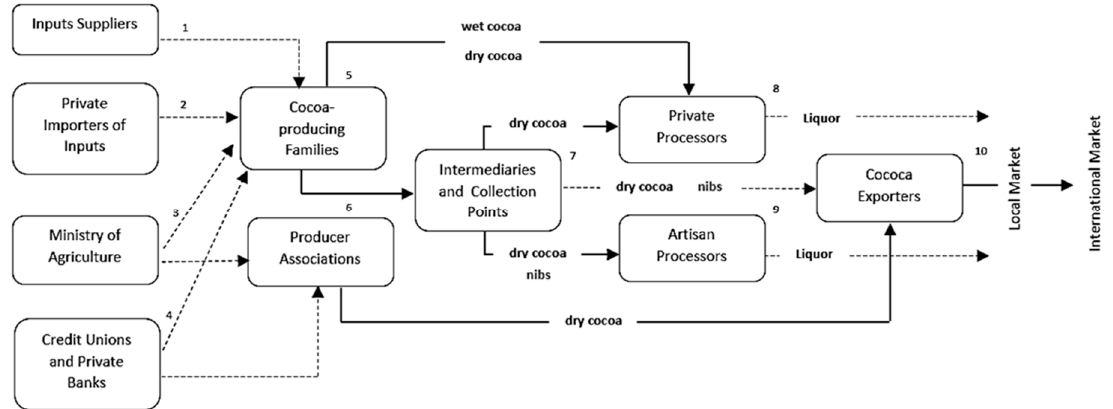
Figure 4. Mapping of the Cocoa Chain at Los Ríos District.